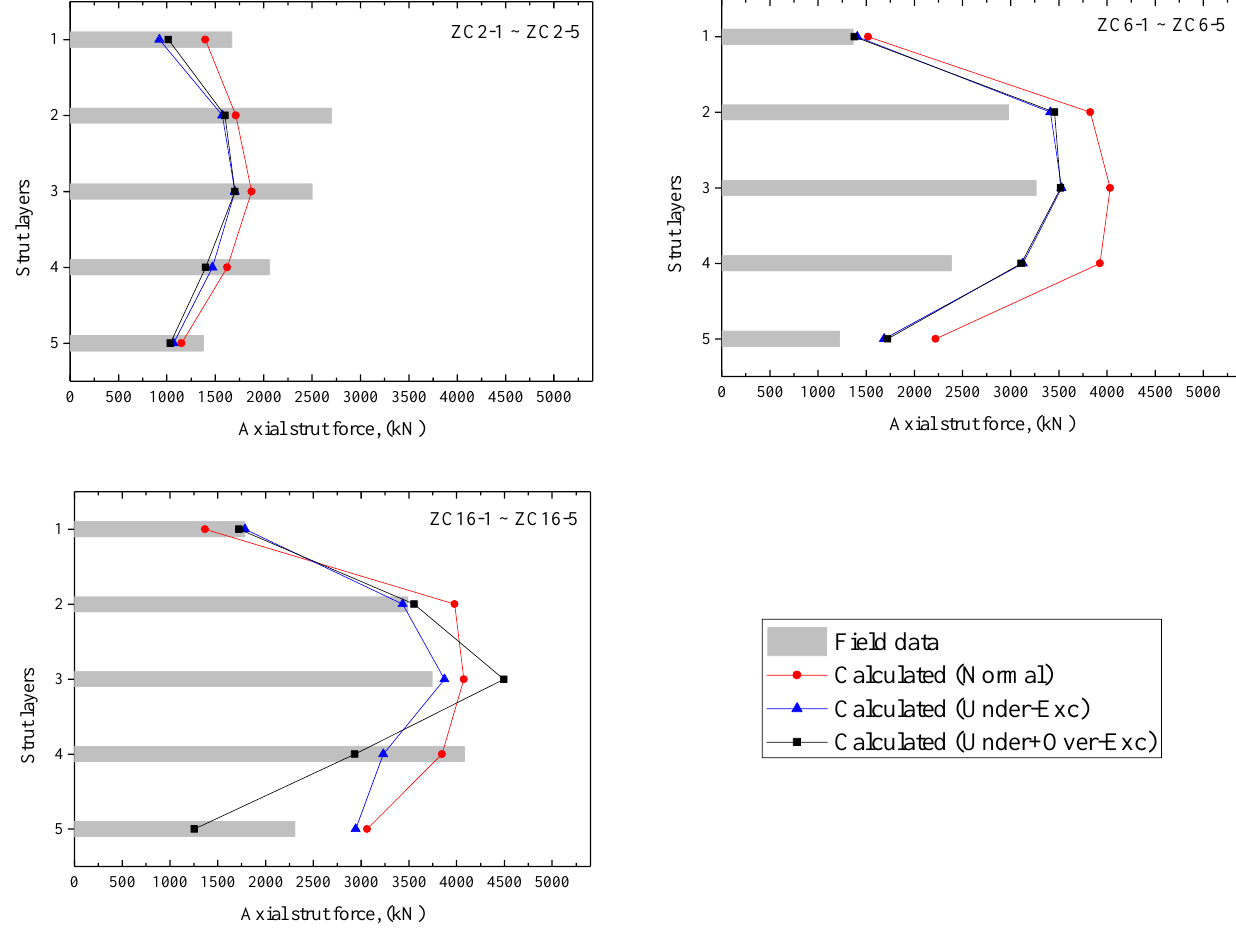
Figure 26. Axial forces at the monitored points ZC2, ZC6, and ZC16.